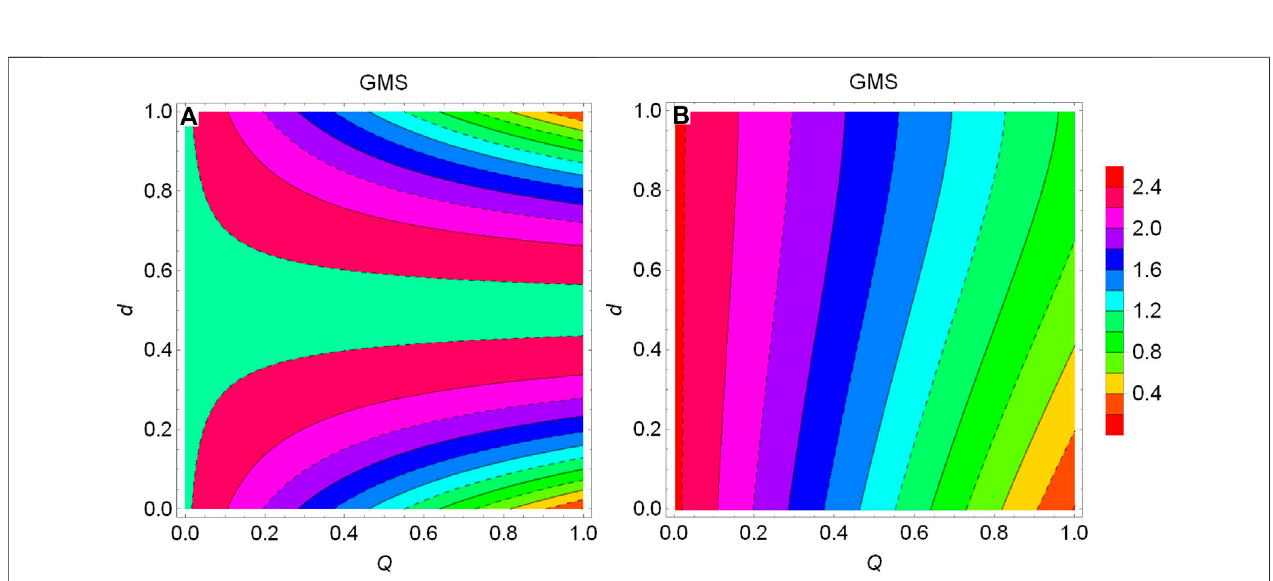
(cid:8)(cid:8) √ 2 /2 under the different noisy